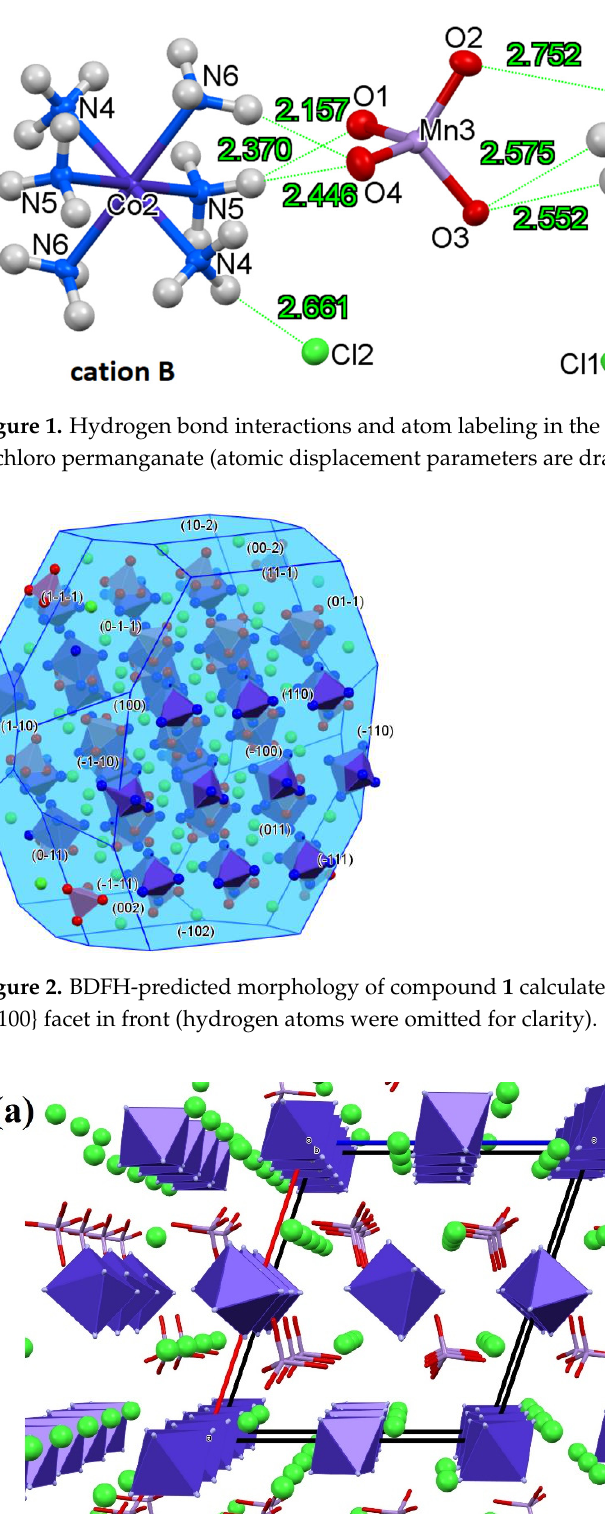
Figure 3. ( a ) Packing arrangement in the crystal of hexaamminecobalt (III) dichloro permanganate. ( b ) Packing arrangement in the crystal of compound 1 from various directions. Different cation lay- ers are indicated by colored rectangles. Layers of cation A are indicated by yellow and layers of cation B are indicated by gray (the structure is drawn in stick representation).